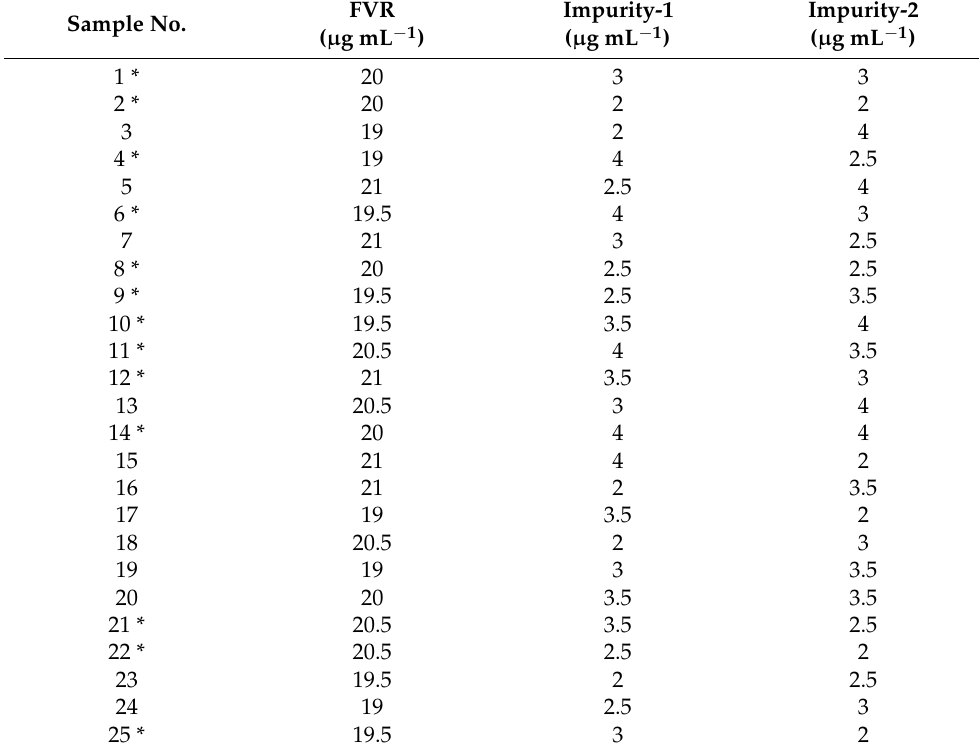
Table 5. The concentrations of FVR and the impurities in the laboratory prepared mixtures used in the calibration and validation